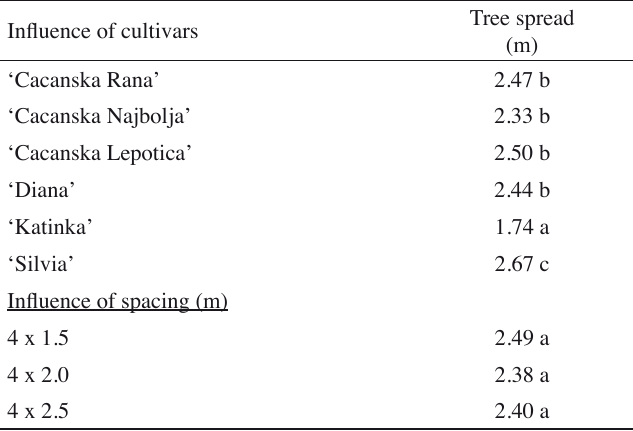
Table 3 - Influence of cultivars and spacing on tree growth expressed by tree spread in the fourth year from planting